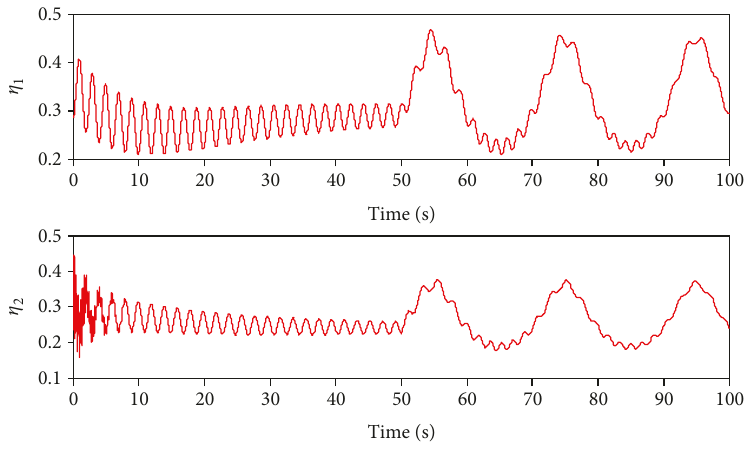
Figure 6: Variation curves of fl exible states.